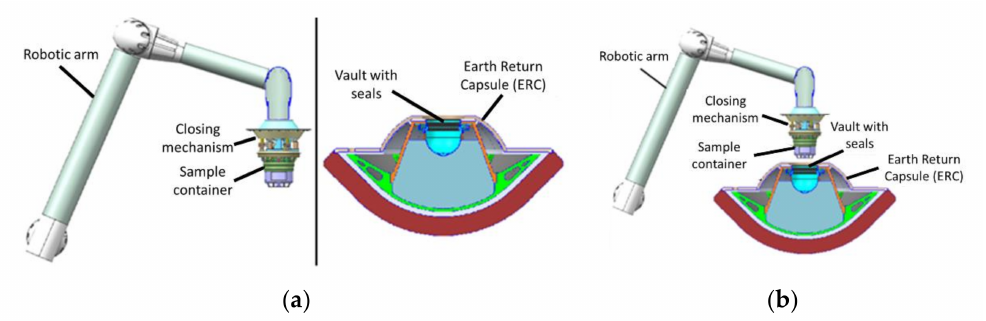
Figure 3. Sample return configuration: ( a ) after regolith sampling in the SC; ( b ) prior to performing the closing operation (images courtesy: Airbus Defence and Space